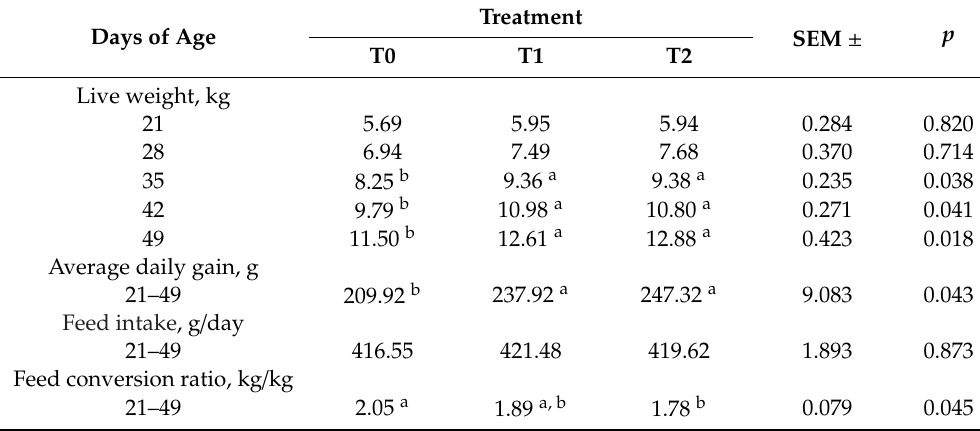
Table 2. E ff ect of oral administration with Lactobacillus plantarum CAM6 on the growth performance of weaned pigs.